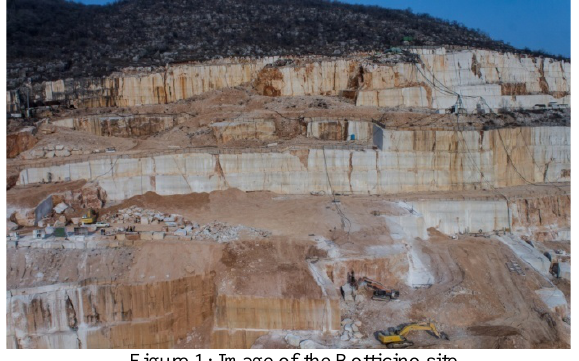
Figure 1: Image of the Botticino site For this reason the technologies used for the full site surveying are usually aerial photogrammetry by UAVs and TLS for the vertical cliffs mapping.